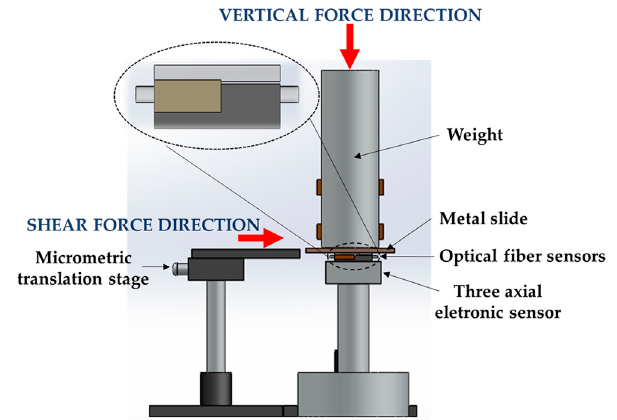
Figure 2. Representation of the experimental setup for the calibration and testing of the fiber Bragg grating (FBGs) cell.